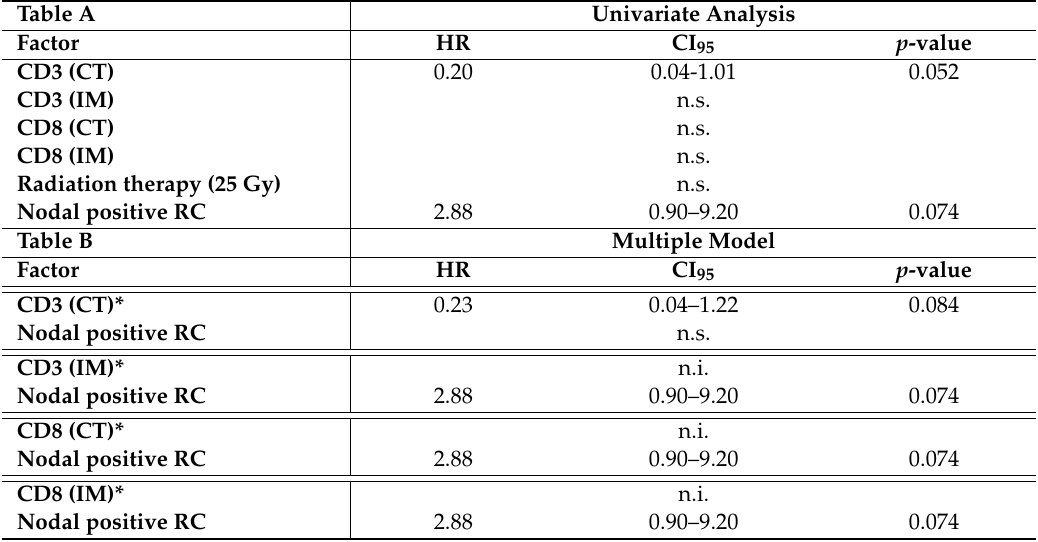
Note. Table A – univariate analysis; Table B – multiple model: double lines indicate separate models; CT: central tumor, IM: invasive margin; HR: hazard ratio, CI: confidence interval; radiation therapy according to